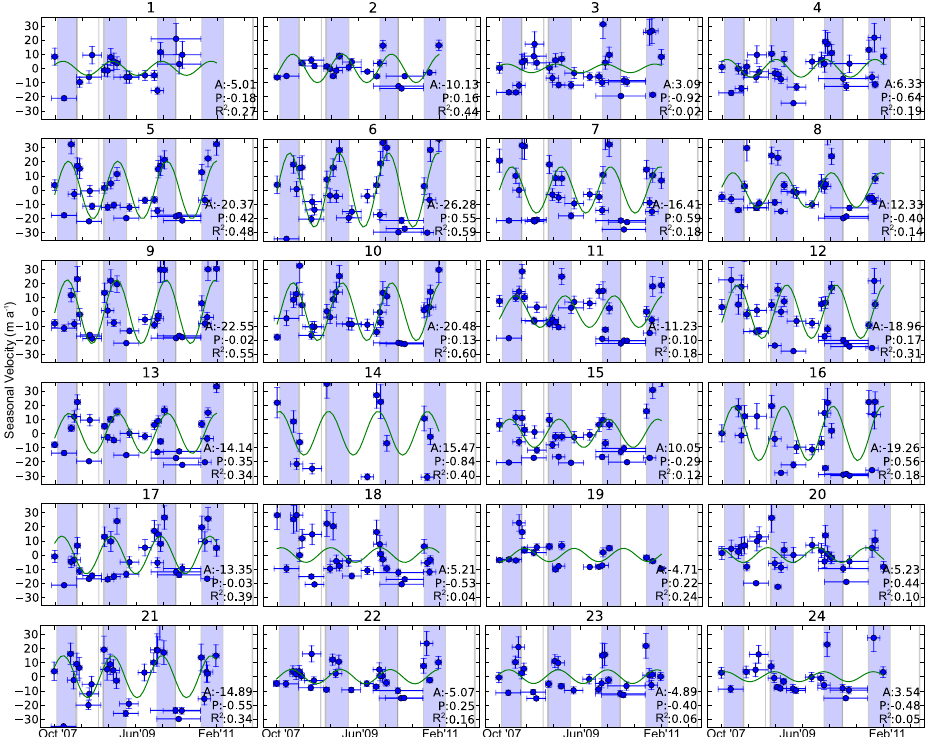
Figure 7. Detrended velocity time series for all analysed tidewater glaciers (see Fig. 2 for location of glaciers 1–24). Velocities are averaged over each glacier’s flux gate and shown as deviations of each glacier’s mean over the period October 2007–March 2011. Fits to a periodic signal and their amplitude A , phase P (in partial years) and coefficient of determination R 2 are shown to illustrate the seasonality. Larger amplitudes indicate stronger seasonal effects. Continuous periods with daily air temperature exceeding 0 ◦ C are shaded in blue, using the temperature records from Juan Carlos I weather station (12m a . s . l . , Fig. 1). Horizontal bars indicate the time interval of each measurement (temporal